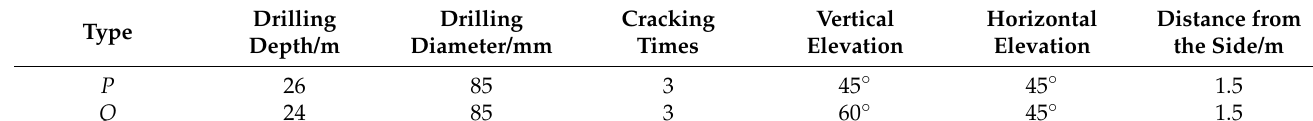
Figure 18. Layout of hydraulic fracturing boreholes in the 18506 working face: ( a ) layout of the drill- ings; ( b ) type P borehole; ( c ) type Q borehole.